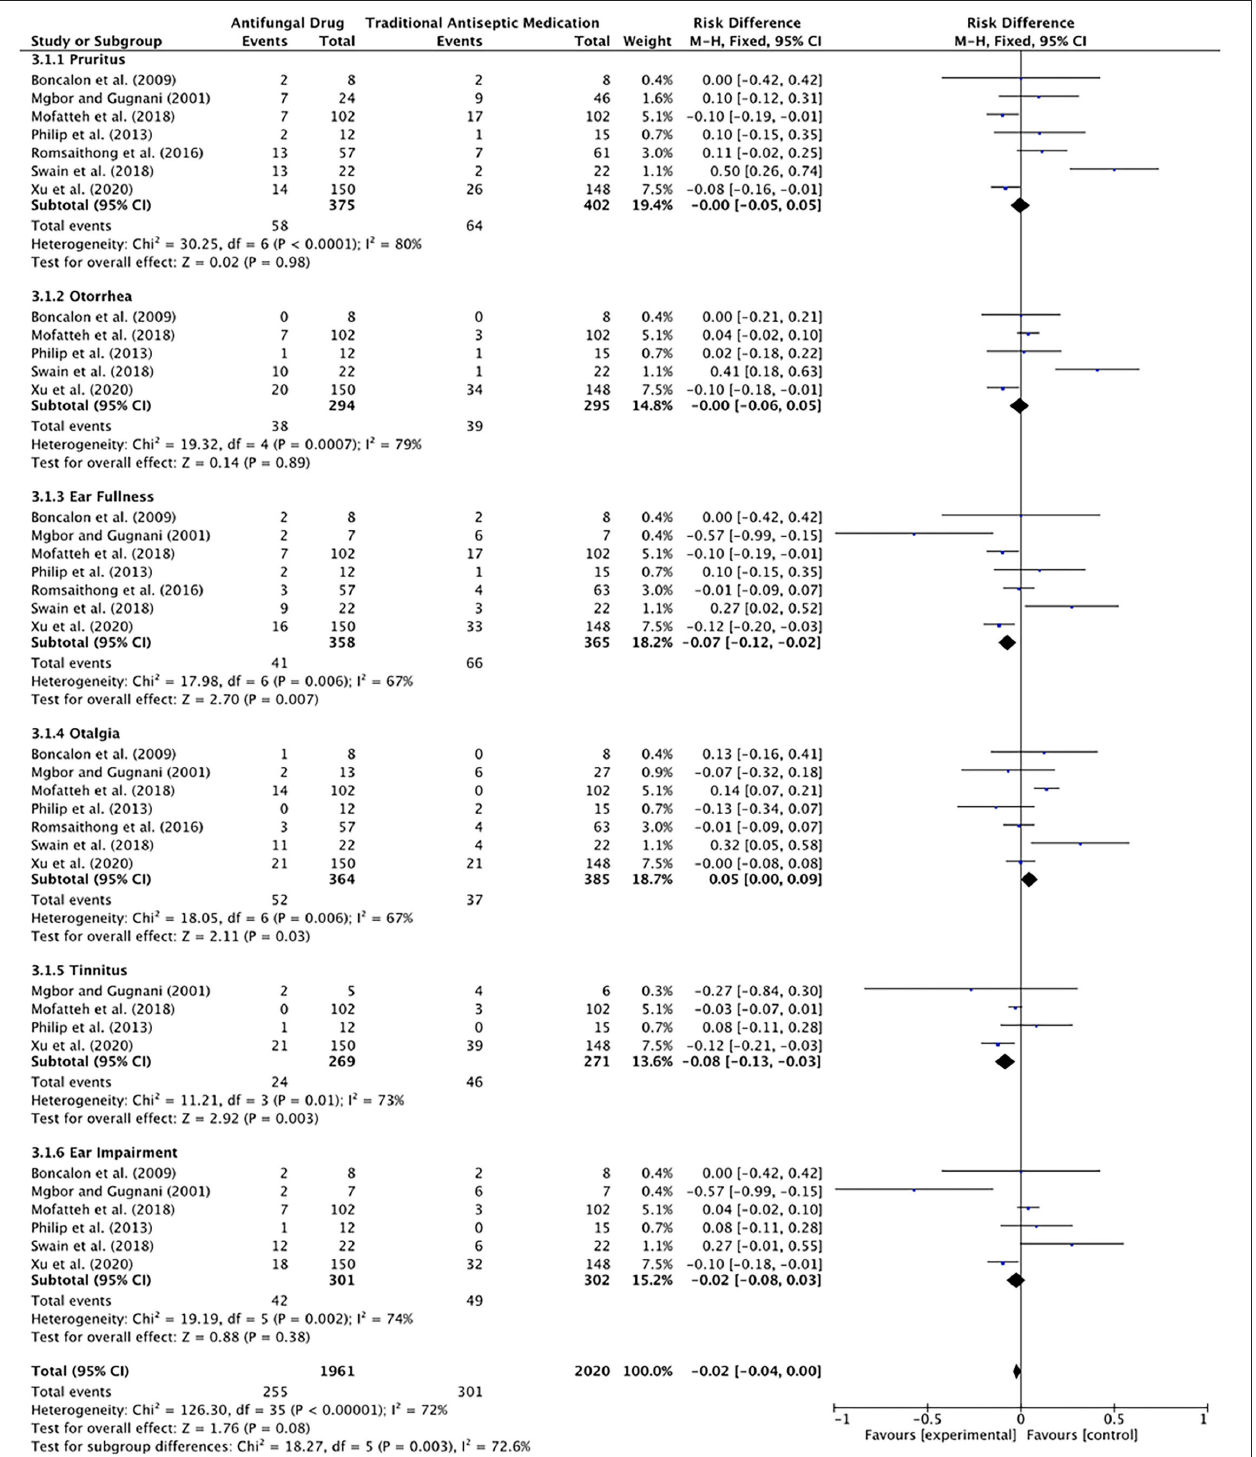
FIGURE 8 | Forest plot of complications associated with the two drug regimens analyzed in the meta-analysis.